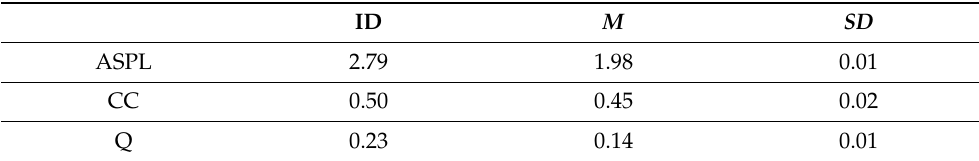
Table A7. Random Network comparison for the network of the adolescents with ID (dataset 6), p < 0.001 for all comparisons.